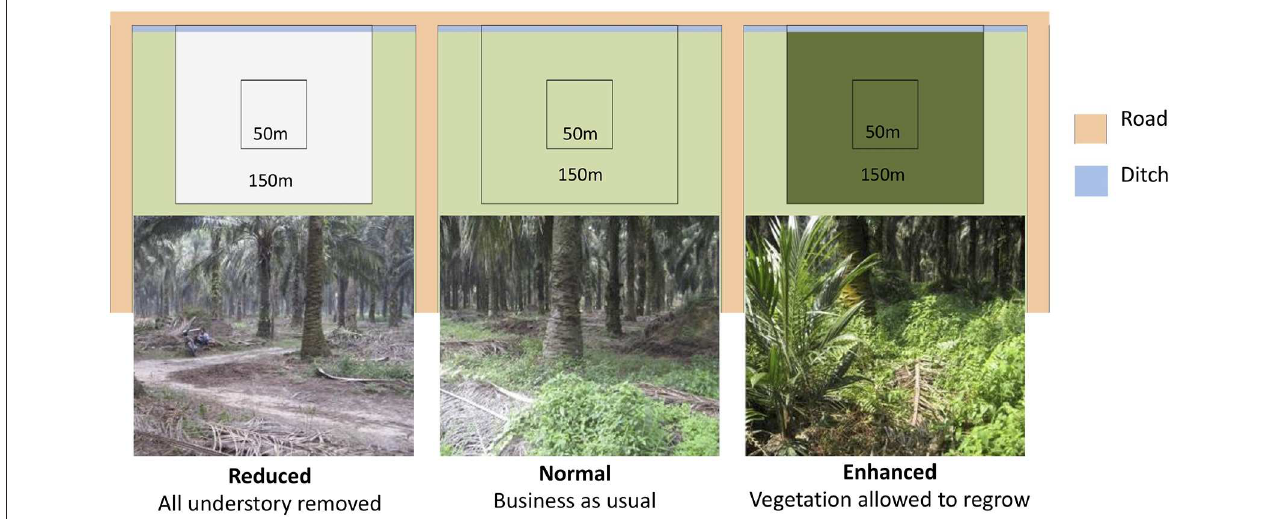
FIGURE 1 | One triplet of plots showing the three experimental vegetation treatments. Photographs of the plantations were taken 2 years after the treatments were implemented. Experimental plots within the triplet are seperated by 150m of plantation and ∼ 5m of road.